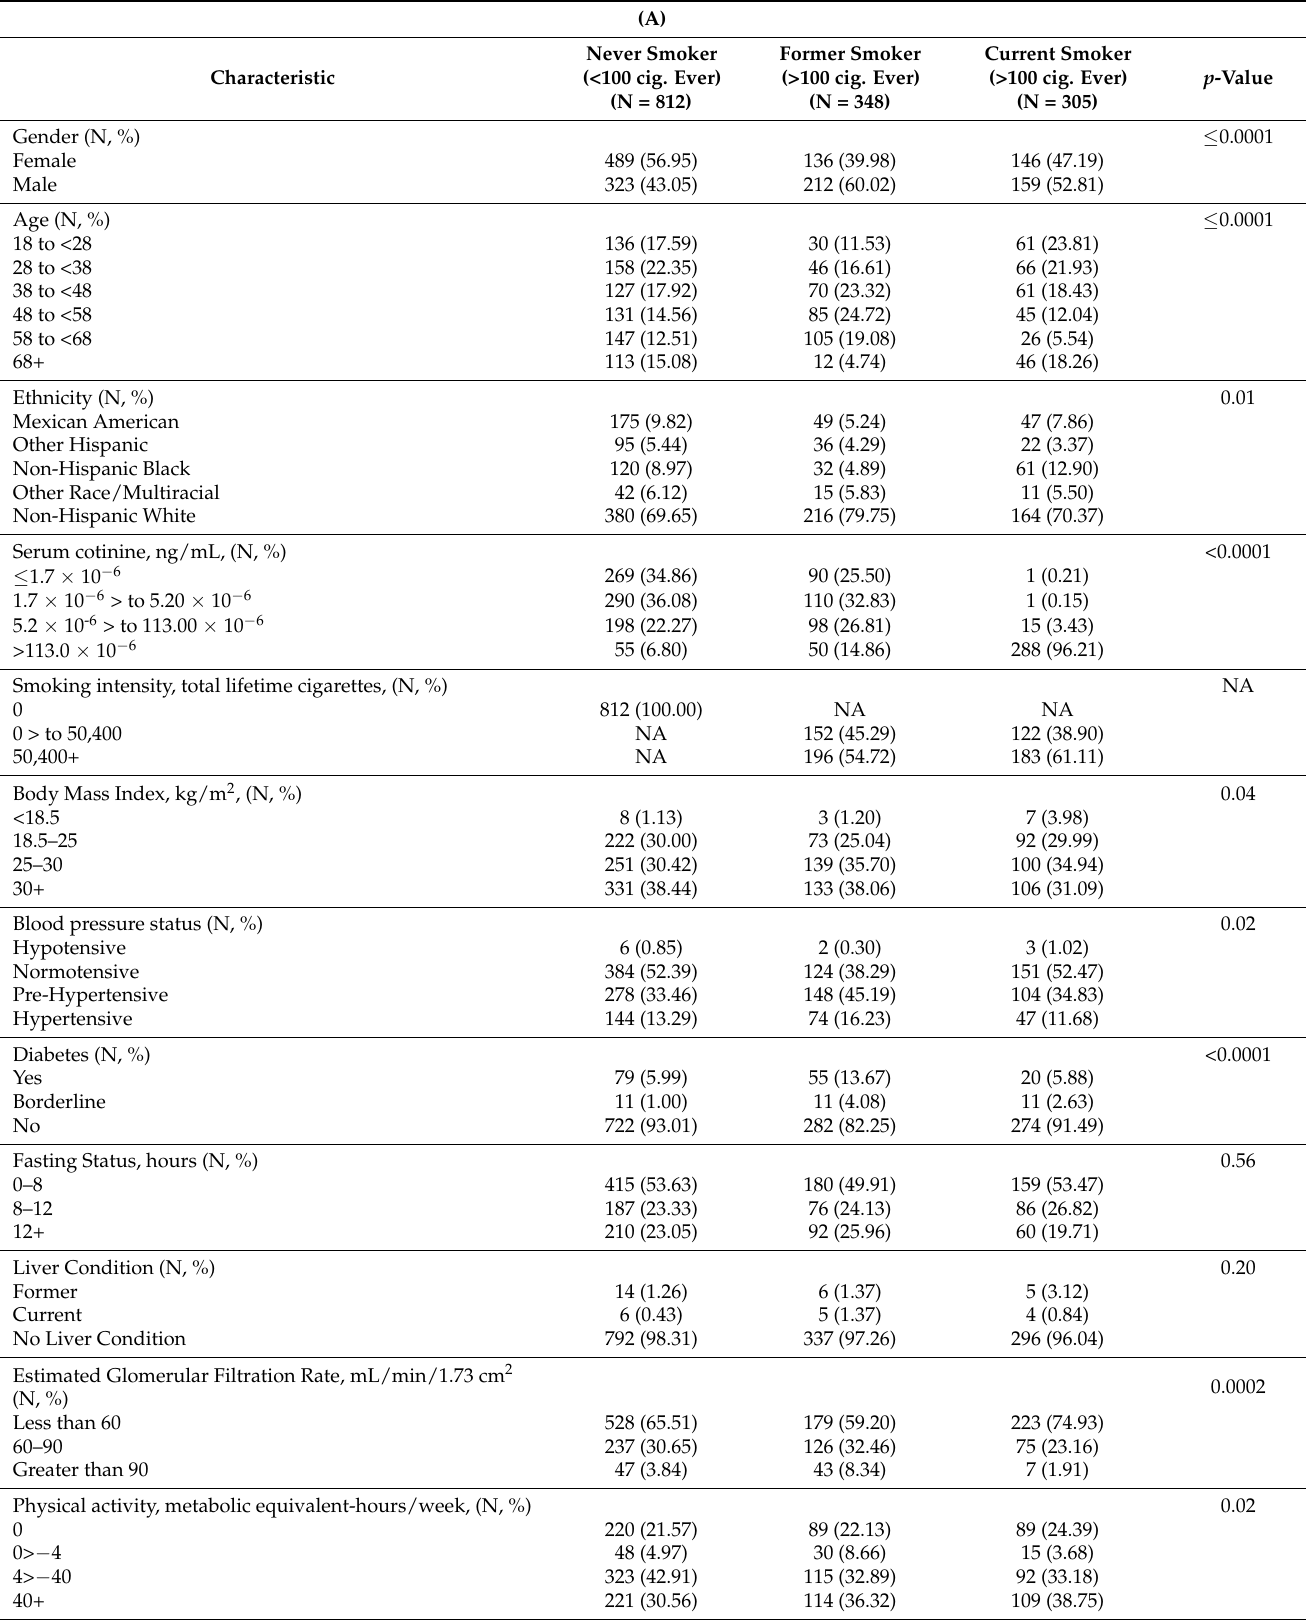
Table 1. ( A ) Demographic characteristics in selected 2009–2010 NHANES participants ( n = 1465); ( B ) liver enzyme levels by smoking status in the selected NHANES 2009–2010 participants ( n =